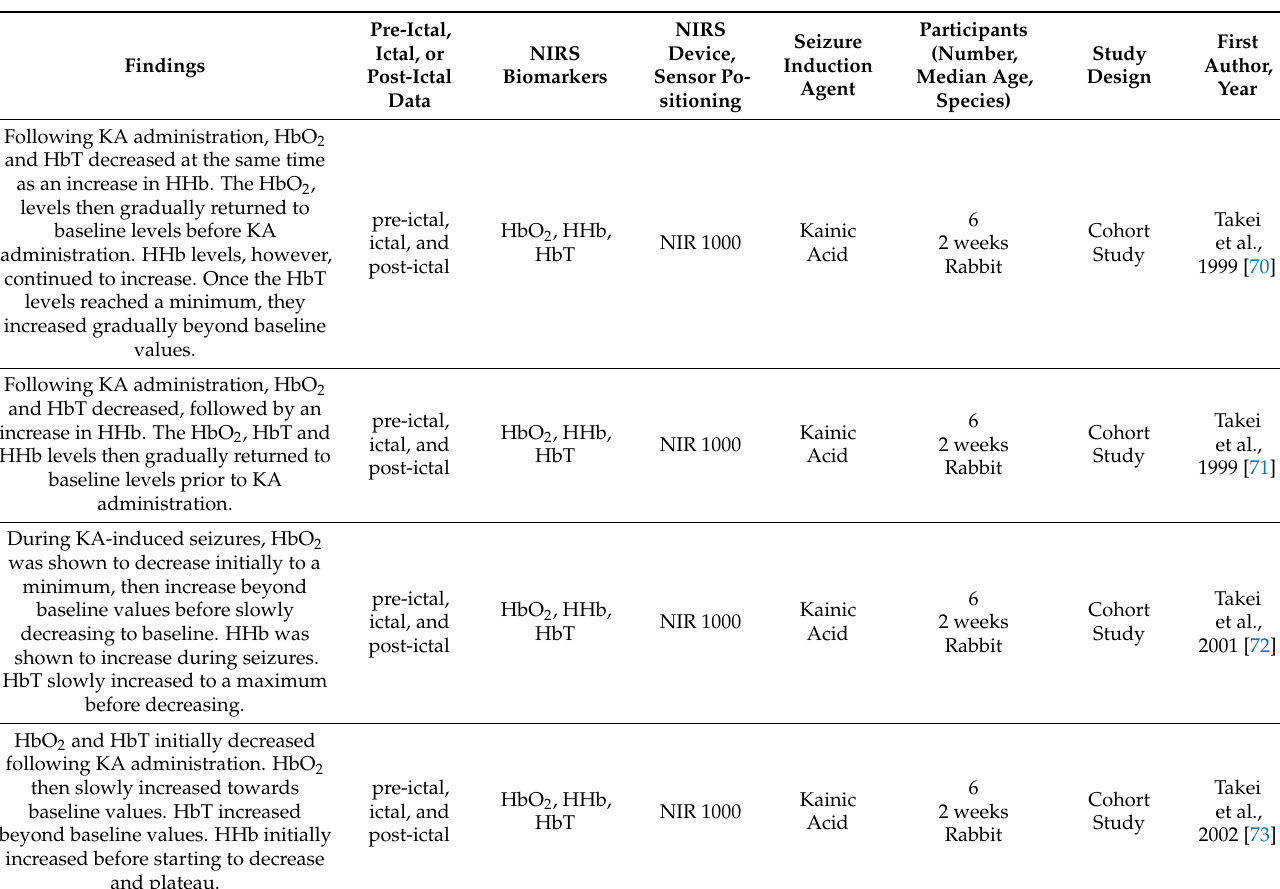
Table 2. Preclinical data extracted from the included